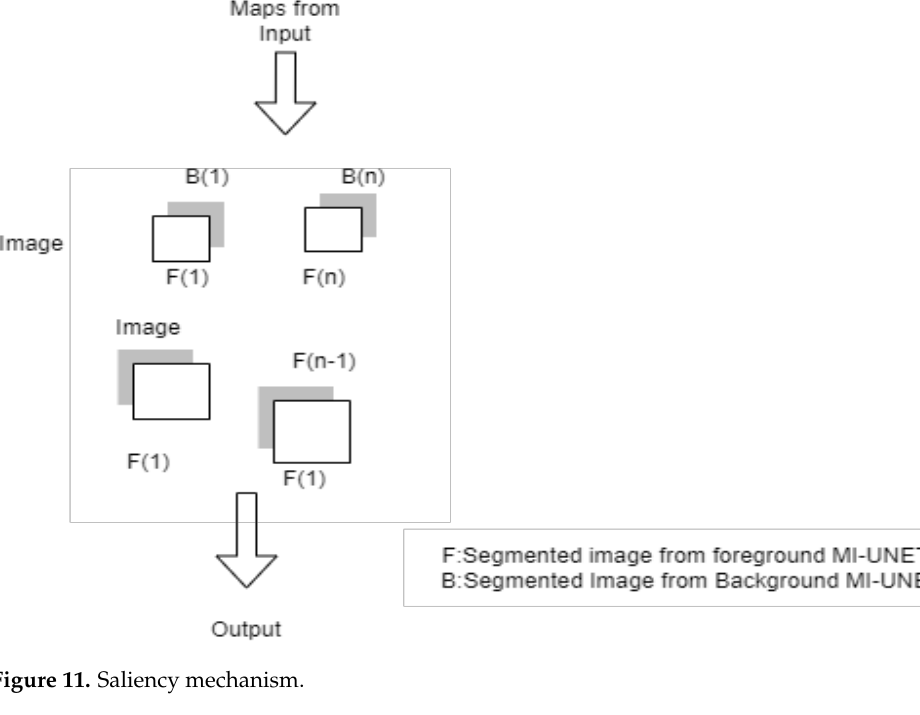
Figure 12. Part of AS-UNET. 3.3.2. RIC-UNET The multi-scale residual inception block and channel gate are applied in RIC UNET [33]. The residual inception block extracts the multi-scale feature information. Cell con- tour obtained from this network is used to segment the dense cell and reduce the cell